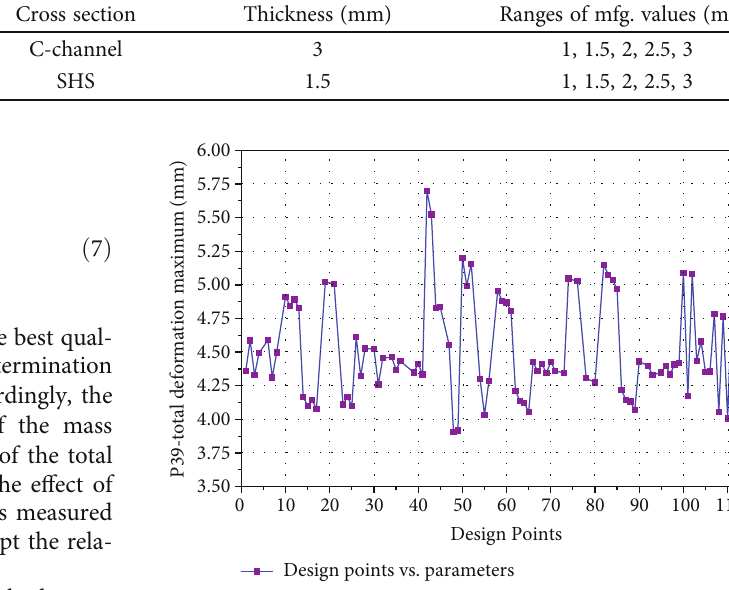
Figure 12: Total deformation (maximum) parameter at each design